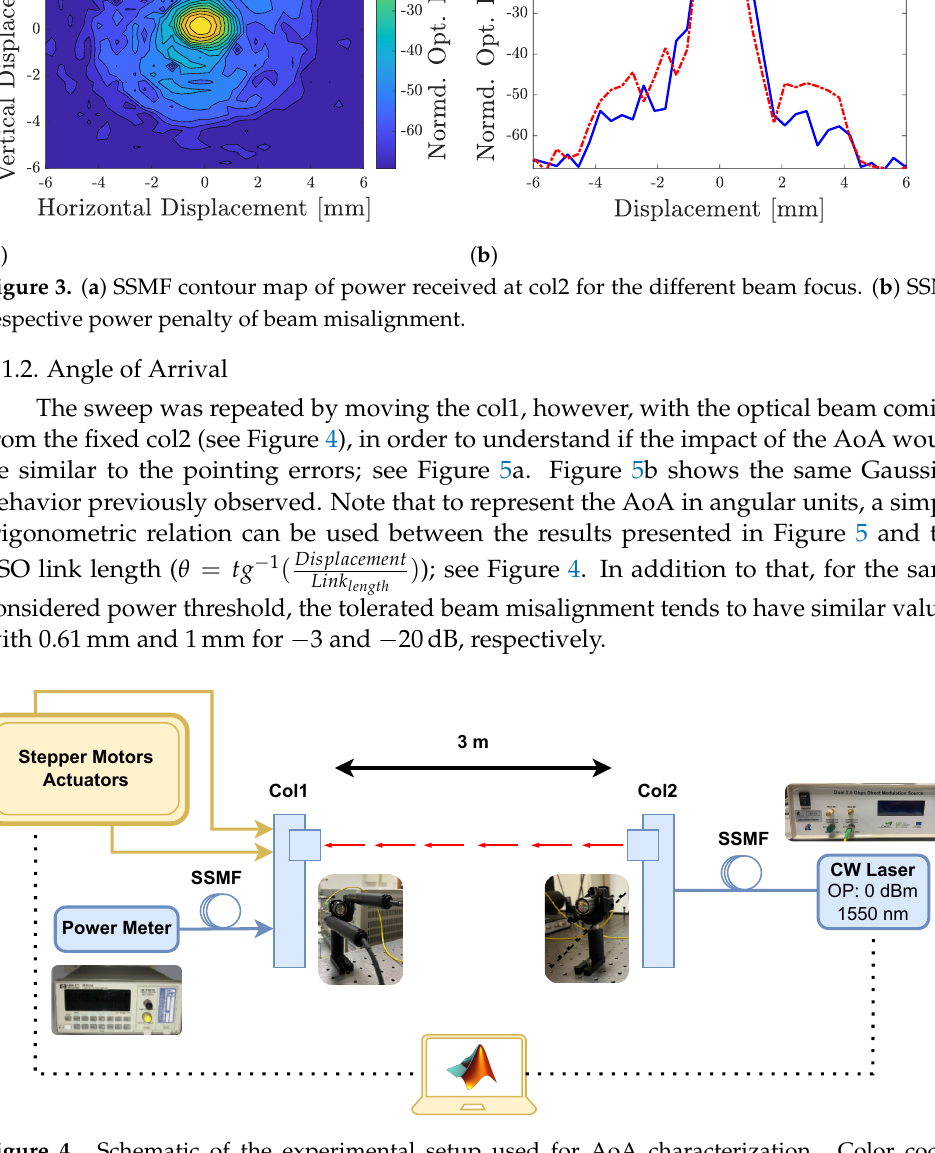
Figure 4. Schematic of the experimental setup used for AoA characterization. Color codes: blue—optical components; yellow—control and measuring